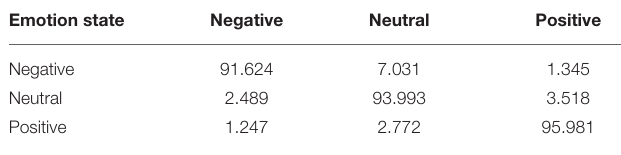
TABLE 4 | Facial emotion recognition confusion matrix during healthcare lecture or electives in medical